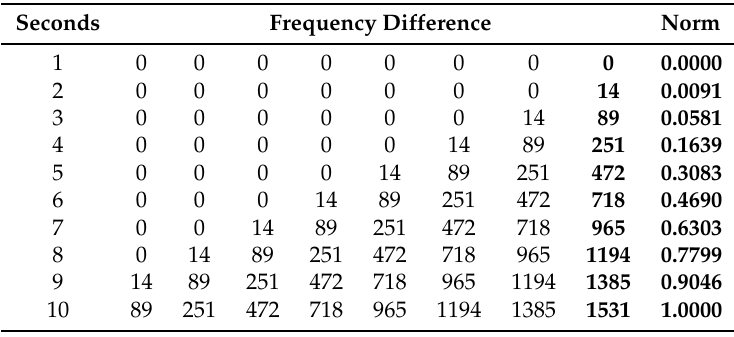
Figure 2. Radar plots for four fruits. Table 1. Response of sensor 1 to melon